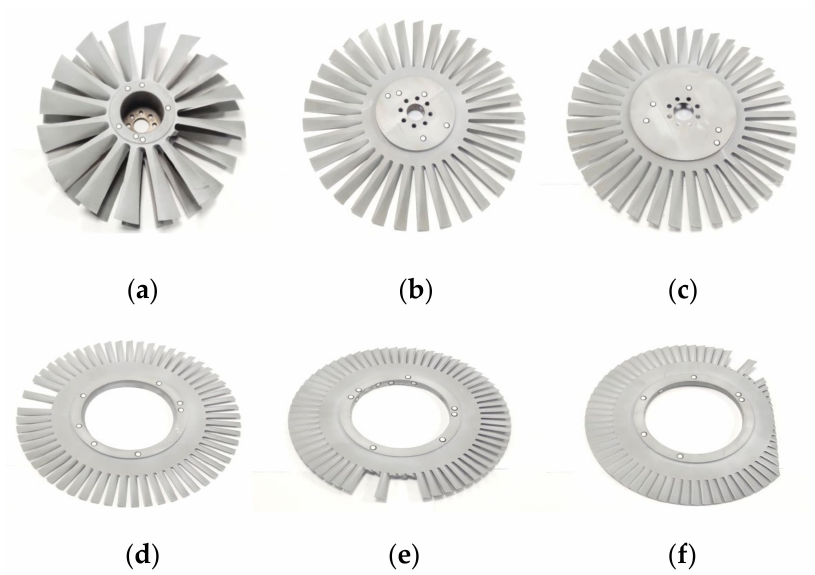
Figure 3. Segmentation of the TMP rotor into six parts for non-contact 3D scanning. ( a ) First-stage and second-stage blades; ( b ) third-stage blade; ( c ) fourth-stage blade; ( d ) fifth-stage blade; ( e ) sixth-stage blade; ( f ) seventh-stage, eighth-stage, and ninth-stage blades.